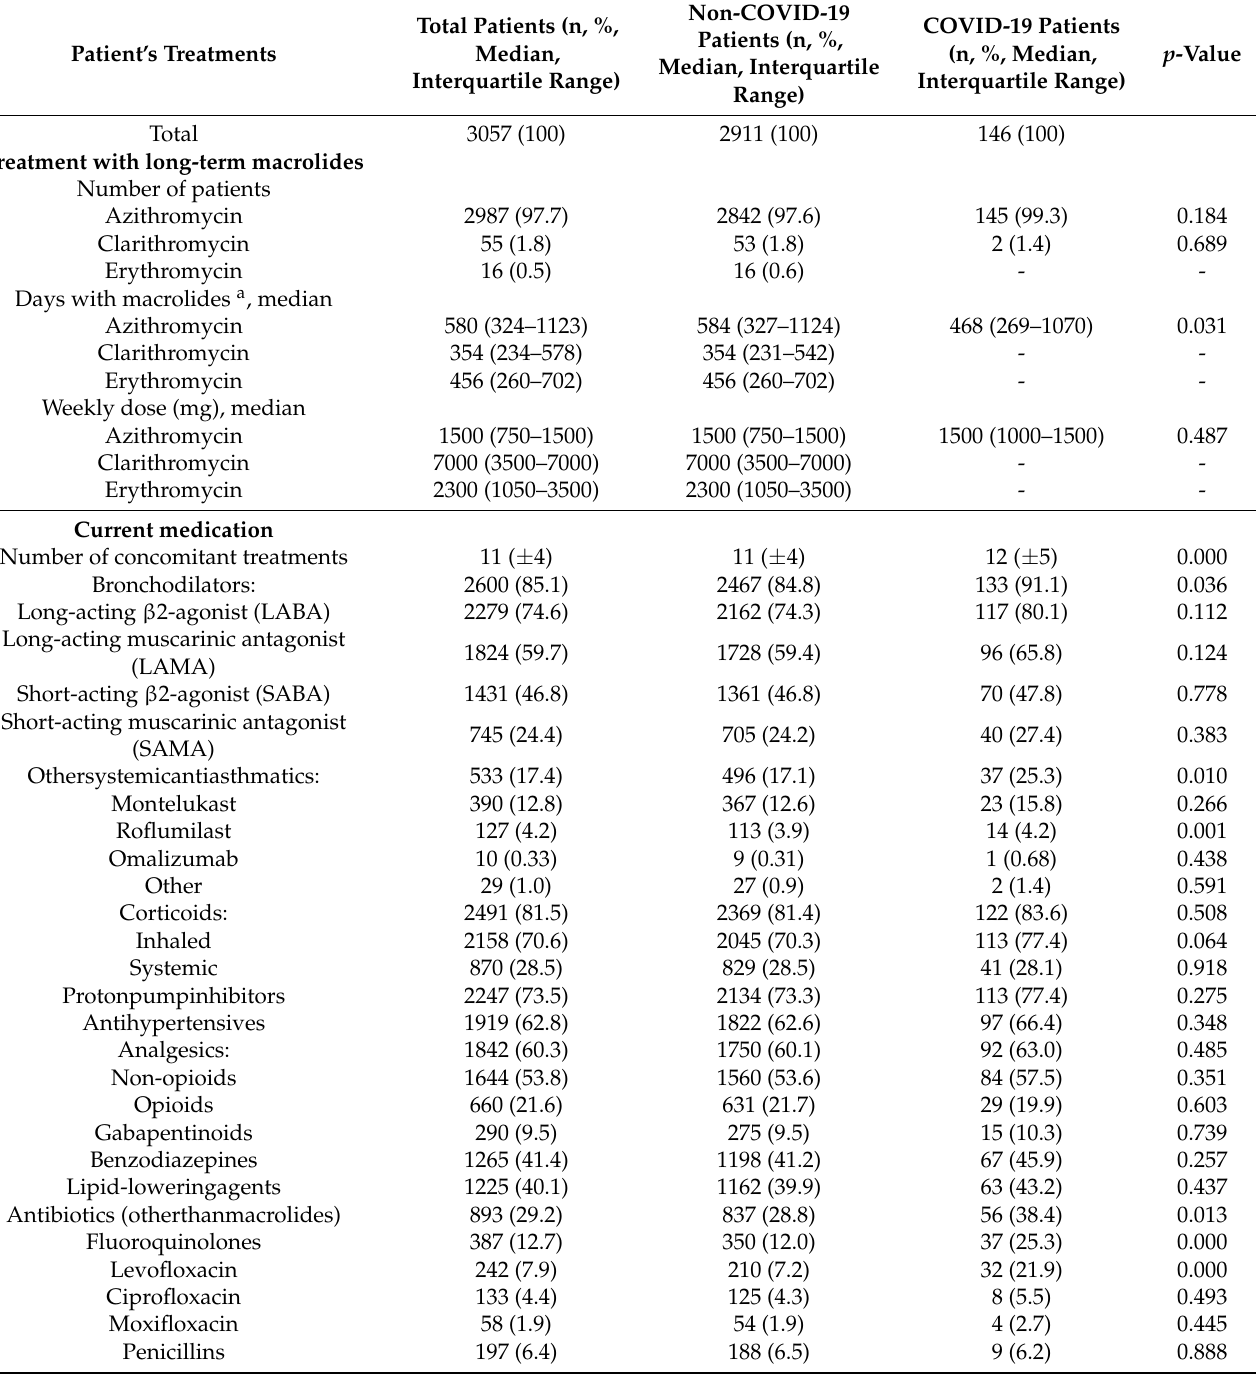
Table 2. Treatments with macrolides and concomitant